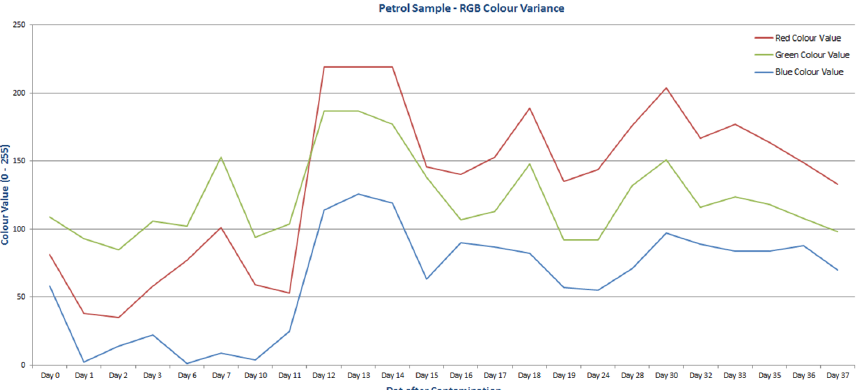
RGB colour values plotted as a function of time after contamination with